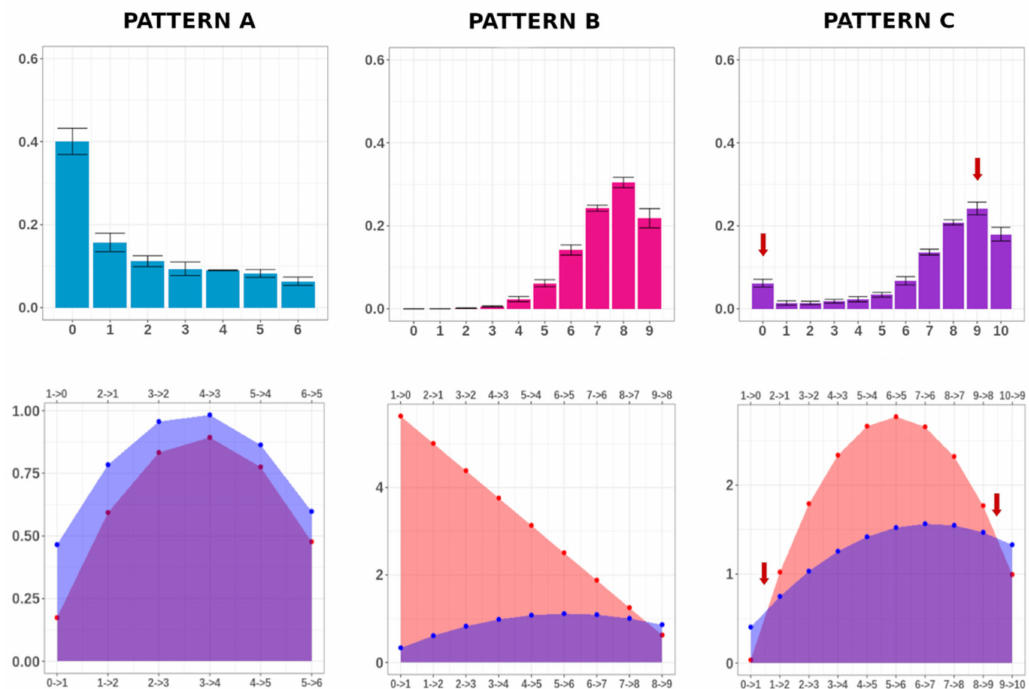
Figure 4. MC frequency distribution and methylation / demethylation rate comparison. For Conditions 6, 17, and 1, the MC average frequencies and the respective standard error (calculated on three individuals) are indicated in the upper panels. For the same conditions, the methylation (red) and demethylation (purple) rates are shown in the lower panels. For Condition 1, DNA methylation and demethylation occur at quite the same rate for molecules with 0 and 9 methylated cytosines (red arrows, lower panel). Notably, these two MCs exhibited the highest average frequency (red arrows, upper panel).